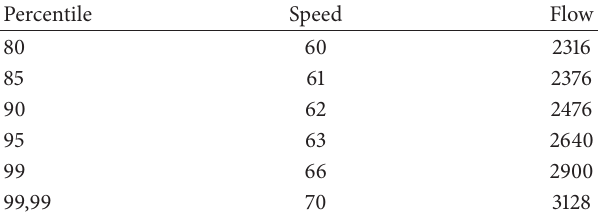
Table 1: Flow and speed percentiles.